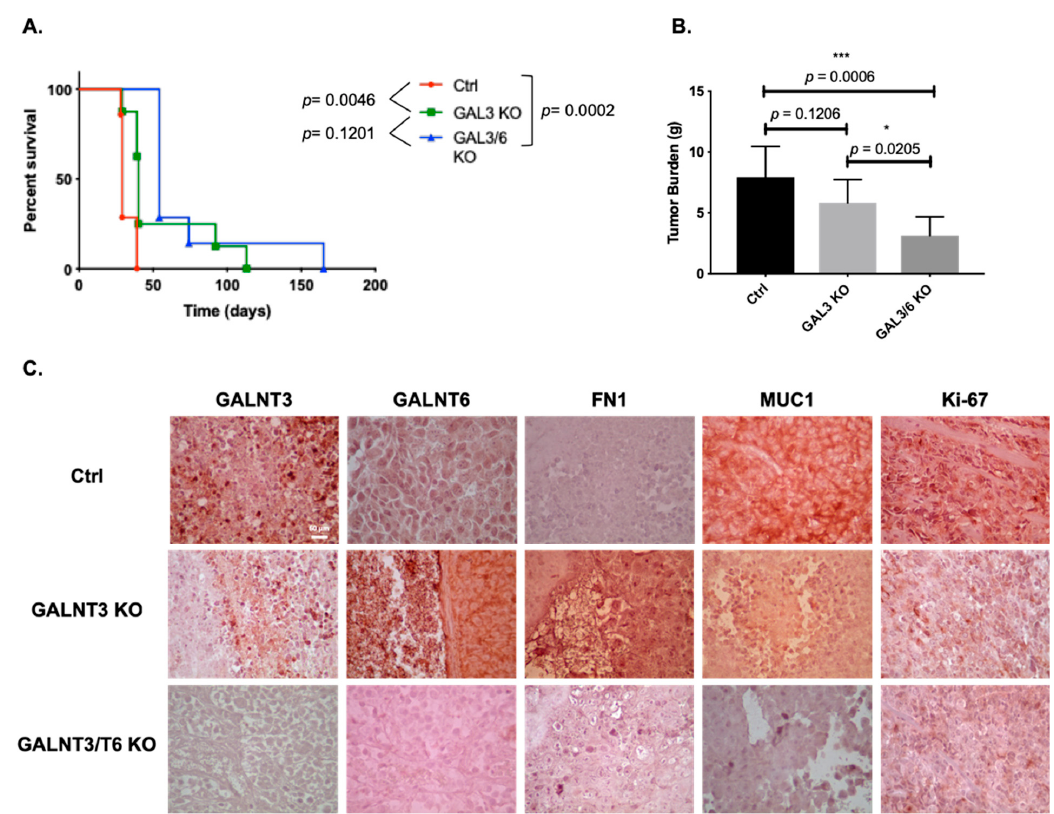
Figure 6. In vivo examination of the effects of GALNT3 and GALNT3/T6 KO in tumor formation and survival in severe combined immunodeficient (SCID) mice. ( A ) Survival curves for mice injected with the Ctrl, GALNT3 KO, and GALNT3/T6 KO EOC cells. Median survival of mice injected with Ctrl cells (32 days, n = 7). Survival of mice injected with the GALNT3 KO cells was significantly improved compared with the vector control ( p = 0.0046, log-rank test), and importantly, mice injected with the GALNT3 / T6 KO cells displayed significantly higher survival rates compared with mice injected with Ctrl cells ( p = 0.0002, log-rank test). ( B ) Tumor weights in SCID mice were measured. Data shown represent the tumor weight averages from seven mice injected with Ctrl cells, eight animals injected with GALNT3 KO cells and seven animals injected with GALNT3 / T6 KO cells. Data are presented as mean ± SEM and were analyzed by one-way ANOVA followed by a Dunnett’s test for multiple comparisons. A significant association was considered when p -values were < 0.05. GraphPad style was used for p -value presentation; p -value symbols refer as follows: ns p > 0.05, * p ≤ 0.05, ** p ≤ 0.01,